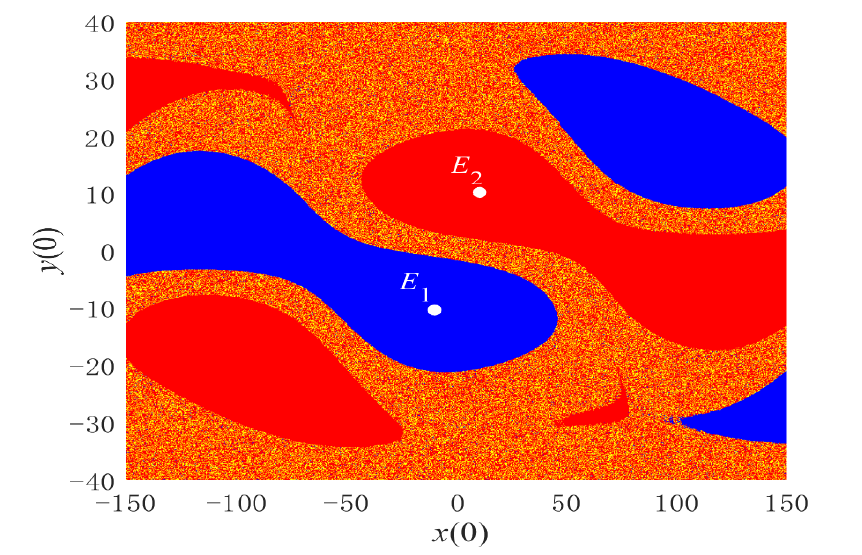
Figure 10. Riddled basins of attraction in x ( 0 ) − y ( 0 ) initial plane with z ( 0 ) =